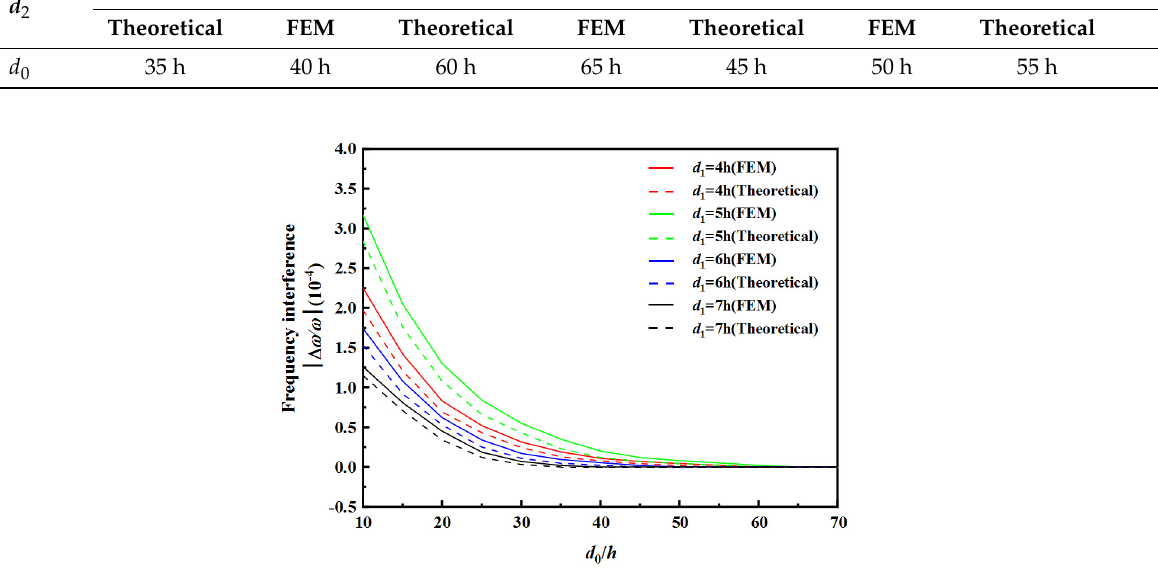
Figure 10. Effect of RU-A’s electrode gap on frequency interference.